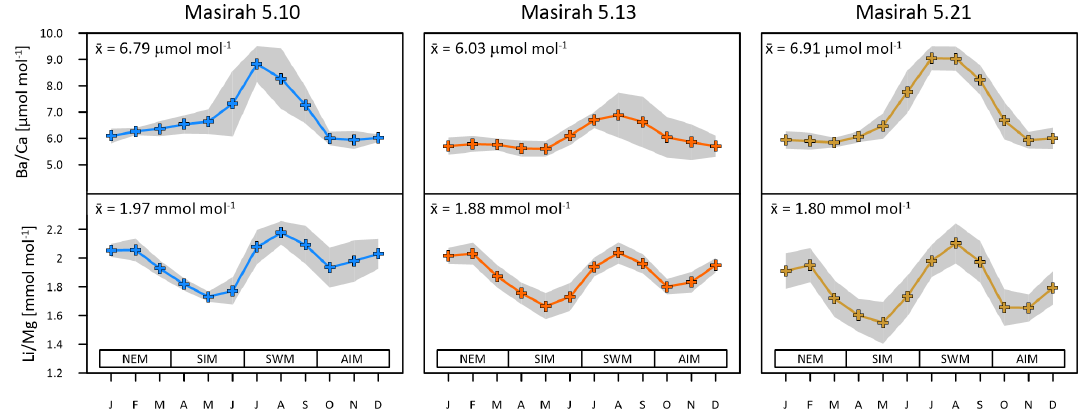
Figure 3. Multi-year monthly means in Ba / Ca and Li / Mg of three Masirah corals (blue, orange, yellow). The grey shaded area represents uncertainty (1 σ ) between equal months of consecutive years. Seasonal abbreviations: NEM (northeast monsoon), SIM (spring intermonsoon), SWM (southwest monsoon), AIM (autumn intermonsoon).